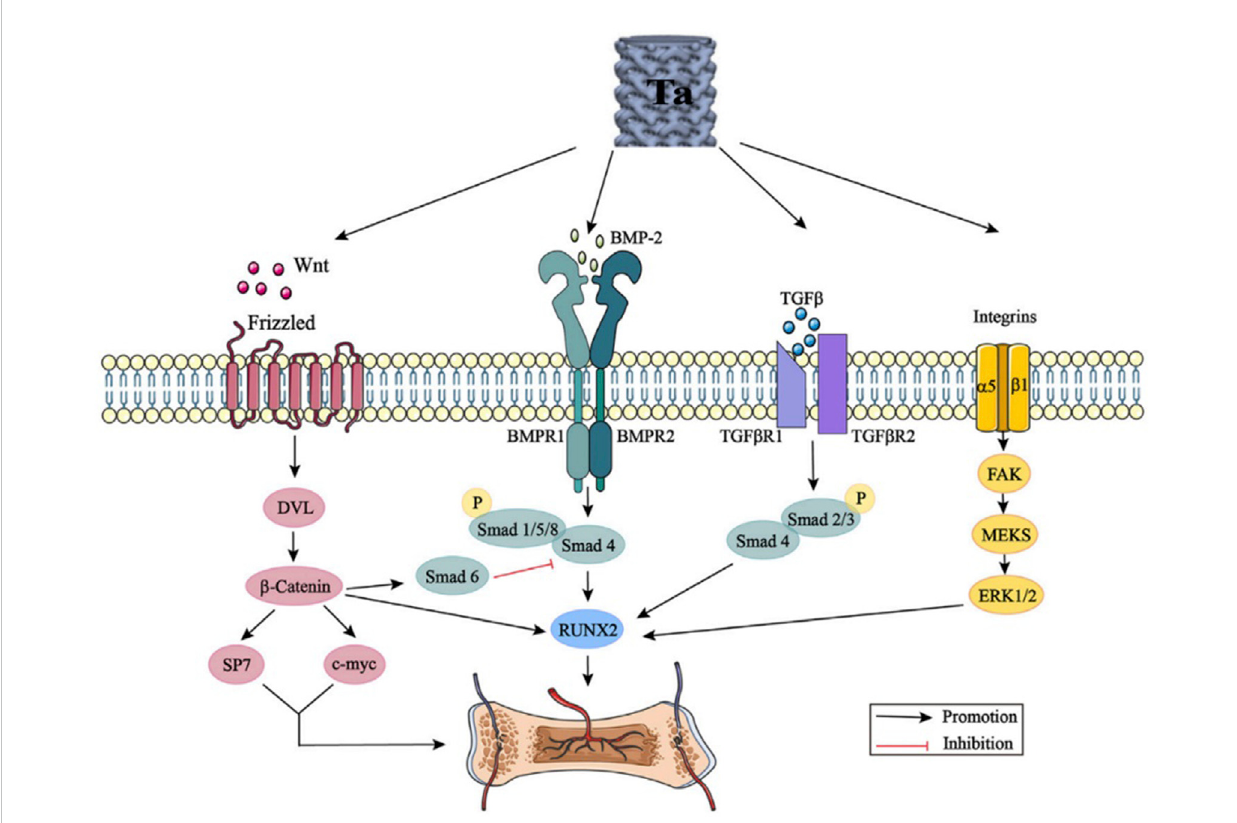
FIGURE 9 Tantalum activates the Wnt/ β -catenin signaling pathway, BMP signaling pathway, TGF- β signaling pathway, and integrin signaling pathway by promoting the expression of Wnt, BMP-2, TGF- β , and integrins. DVL: disheveled; BMP: bone morphogenic proteins; Smad: small mother